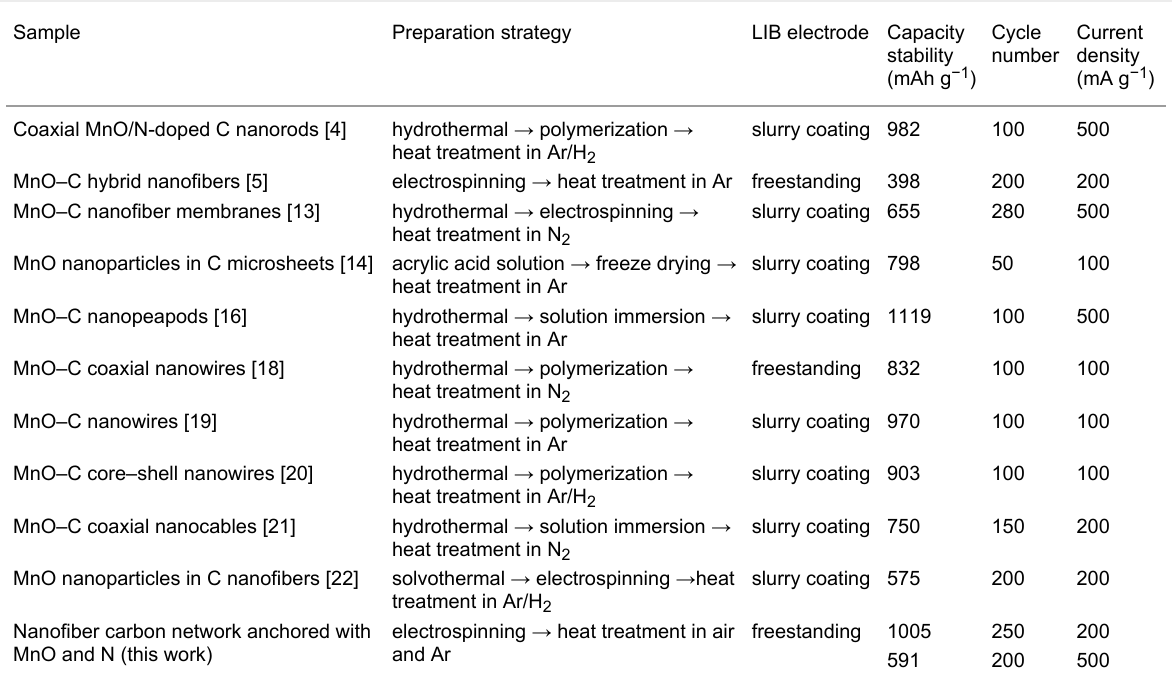
Table 1: Lithium storage performance of some comparable MnO–C-composite-based anodes for lithium-ion batteries (LIBs).